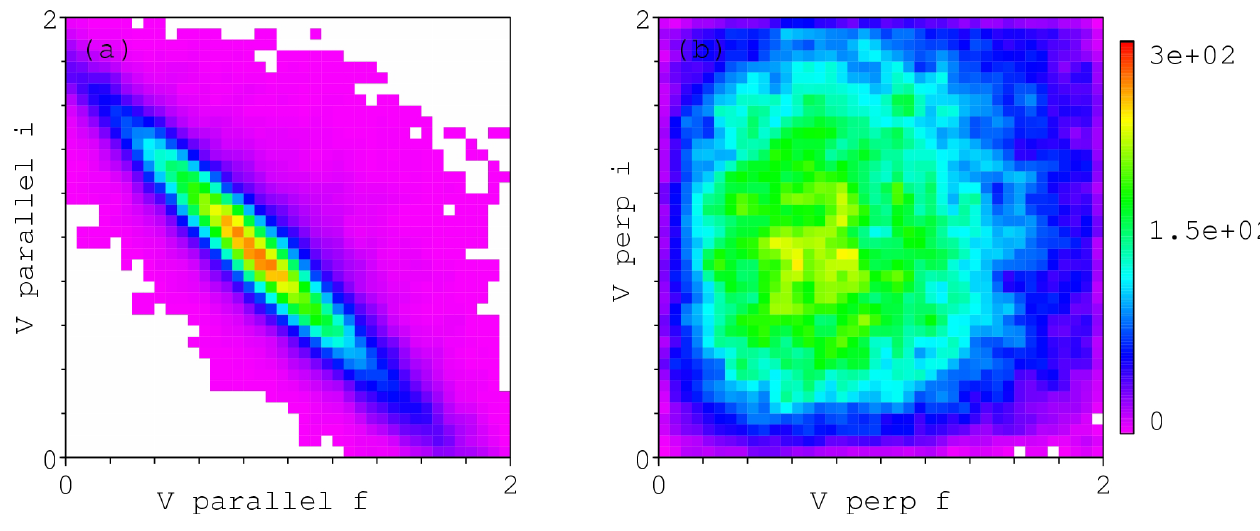
Fig. 12. Color-coded number of particles crossing the magnetic field reversal. Left panel depicts the final value of the parallel velocity, depending on its initial value, and right panel depicts the final value of the perpendicular velocity, depending on its initial value.